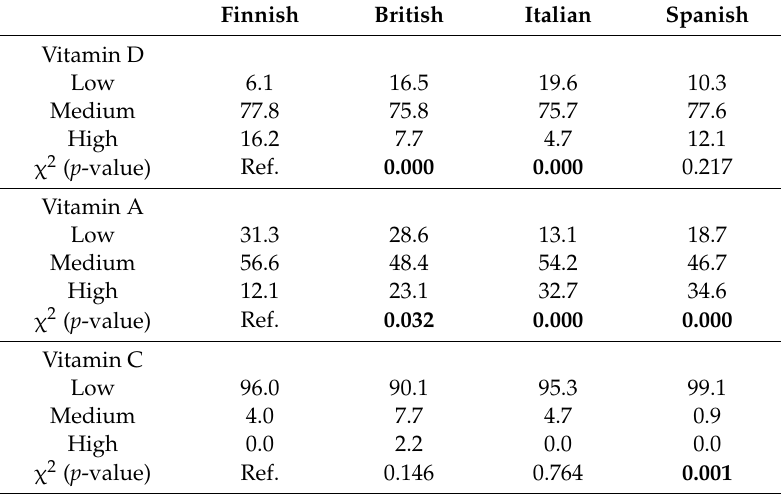
Figure 3. Pearson correlogram of COVID-19 epidemiological parameters: Incidence, Deaths (mortality rate), and Deaths% (relative mortality rate), and immune system micronutrient suboptimal intake. The size and color intensity of the spot indicate the degree of correlation between two parameters. The color red indicates a positive correlation, whereas blue indicates a negative correlation. Pearson correlation p -values ( p ) are indicated below each dot and p < 0.1 are highlighted in bold. Table 3. Genetic risk of lower status of 10 relevant Vitamins and Minerals for proper immune system function. Population% at low, medium, and high risk of low micronutrient status are shown calculated from individual SNP data for European Population (available in 1000genomes database) as described in the Materials and Methods. Statistical assessment of di ff erences in population% at risk ranges for each country was carried out by Chi-Square with Finland used as reference country. p -values in bold means p <